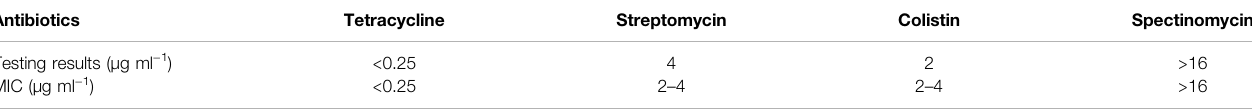
TABLE 2 | The result of AST of E. coli with our proposed method and